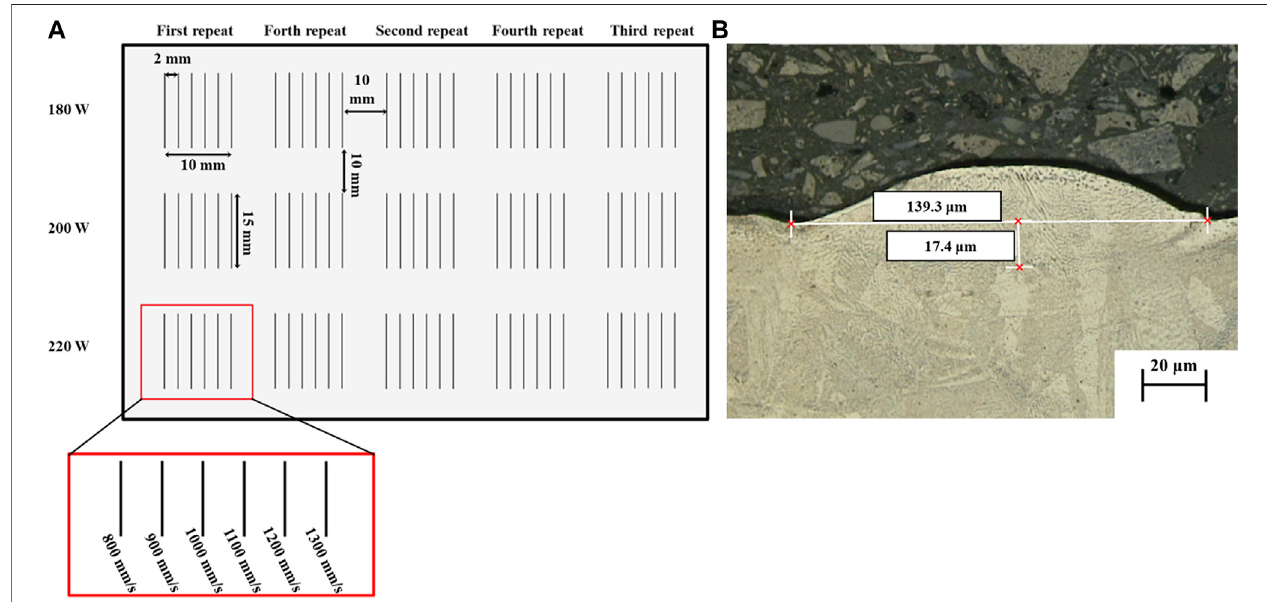
FIGURE 1 | (A) Single track DOE parameters and con fi guration on the powder bed substrate. (B) Optical microscope image showing R65 single track melt pool produced by LPBF with a laser speed of 800 mm/s and power of 200